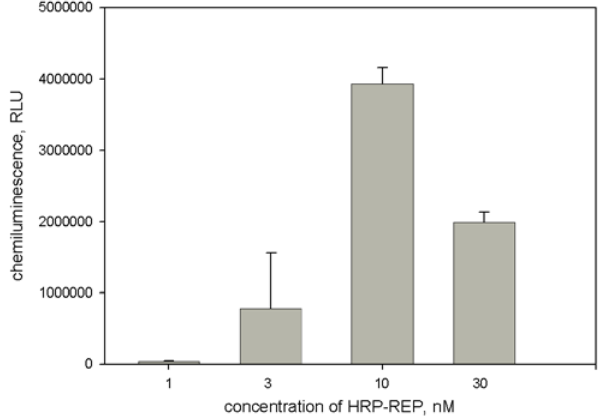
Figure 4. Dependence of light output upon concentration of HRP-REP conjugate. Experimental conditions: concentrations of apoHRP-CAP (5:1) and HBV DNA were 1.7 µg/mL and 1 nM, respectively. Chemiluminescence was measured 8 min after the initiation of luminol oxidation . Each measurement was repeated thrice.